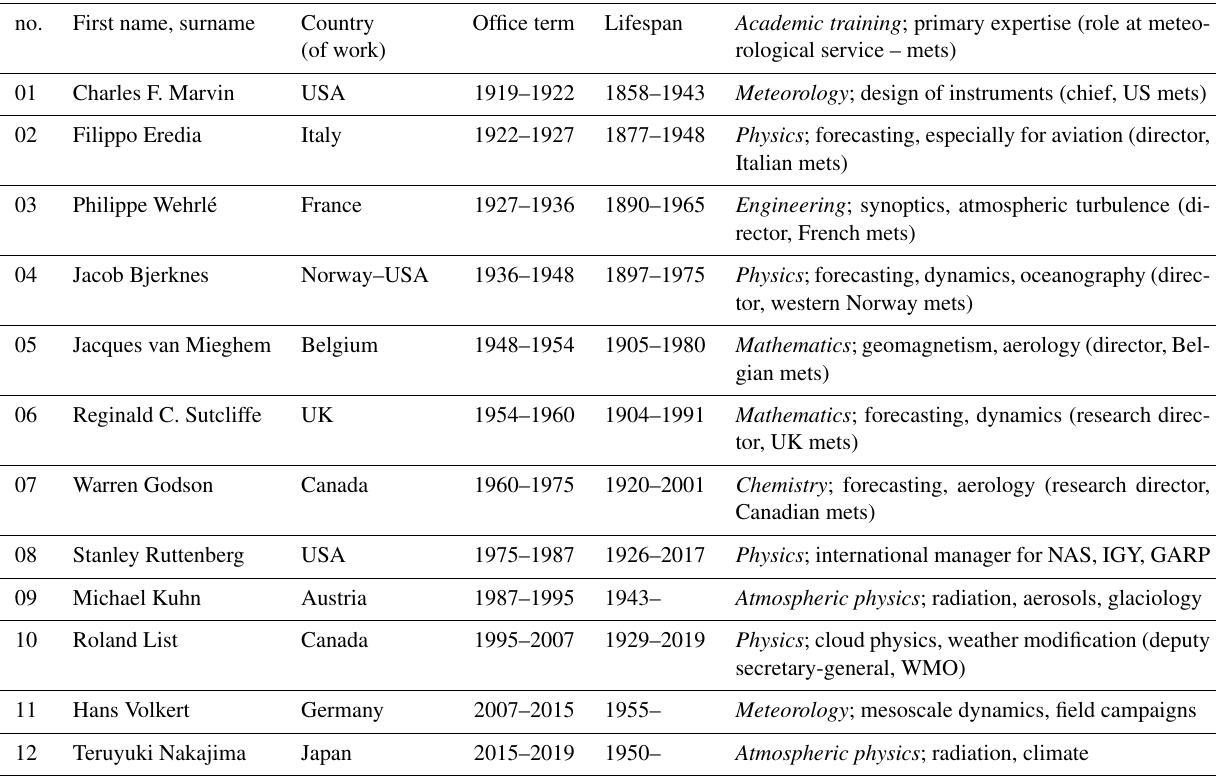
Table 3. Succinct biographical information about the 12 persons who have served as IAMAS secretaries-general; photographs are presented in Fig. 4. Under academic training, the subject of graduation is listed (typically for a PhD or MSc degree).